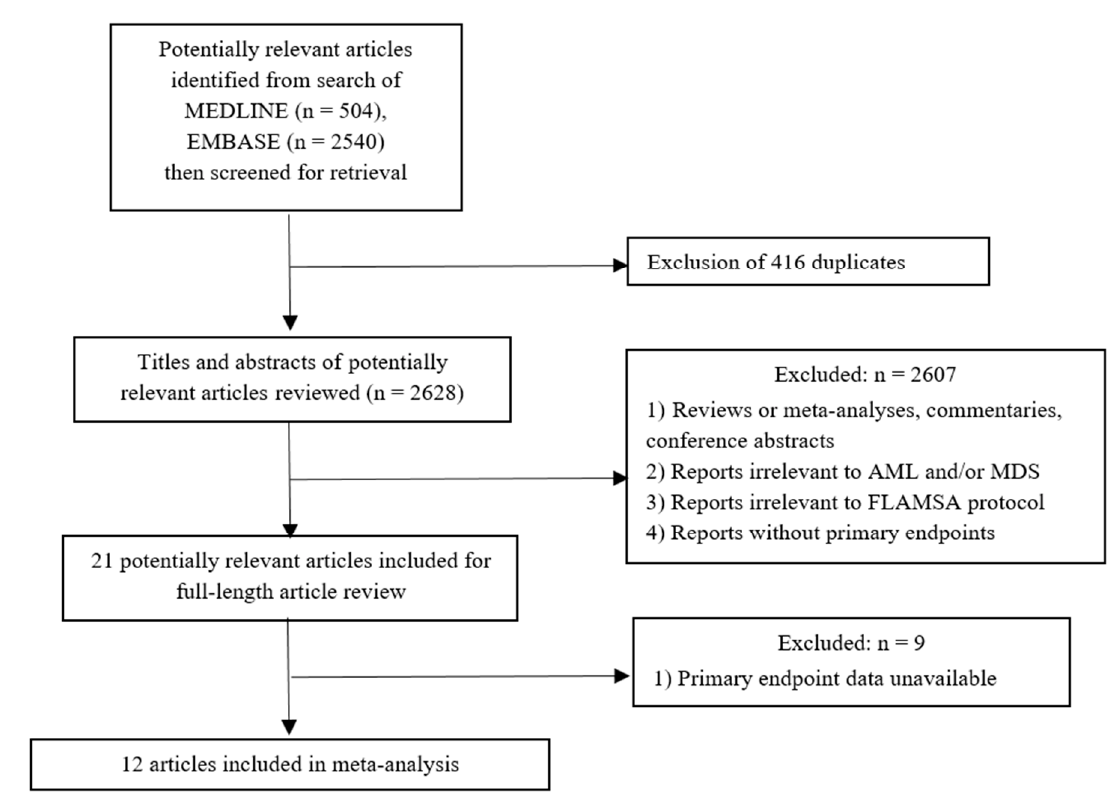
Figure 1. Flowchart of literature review process .